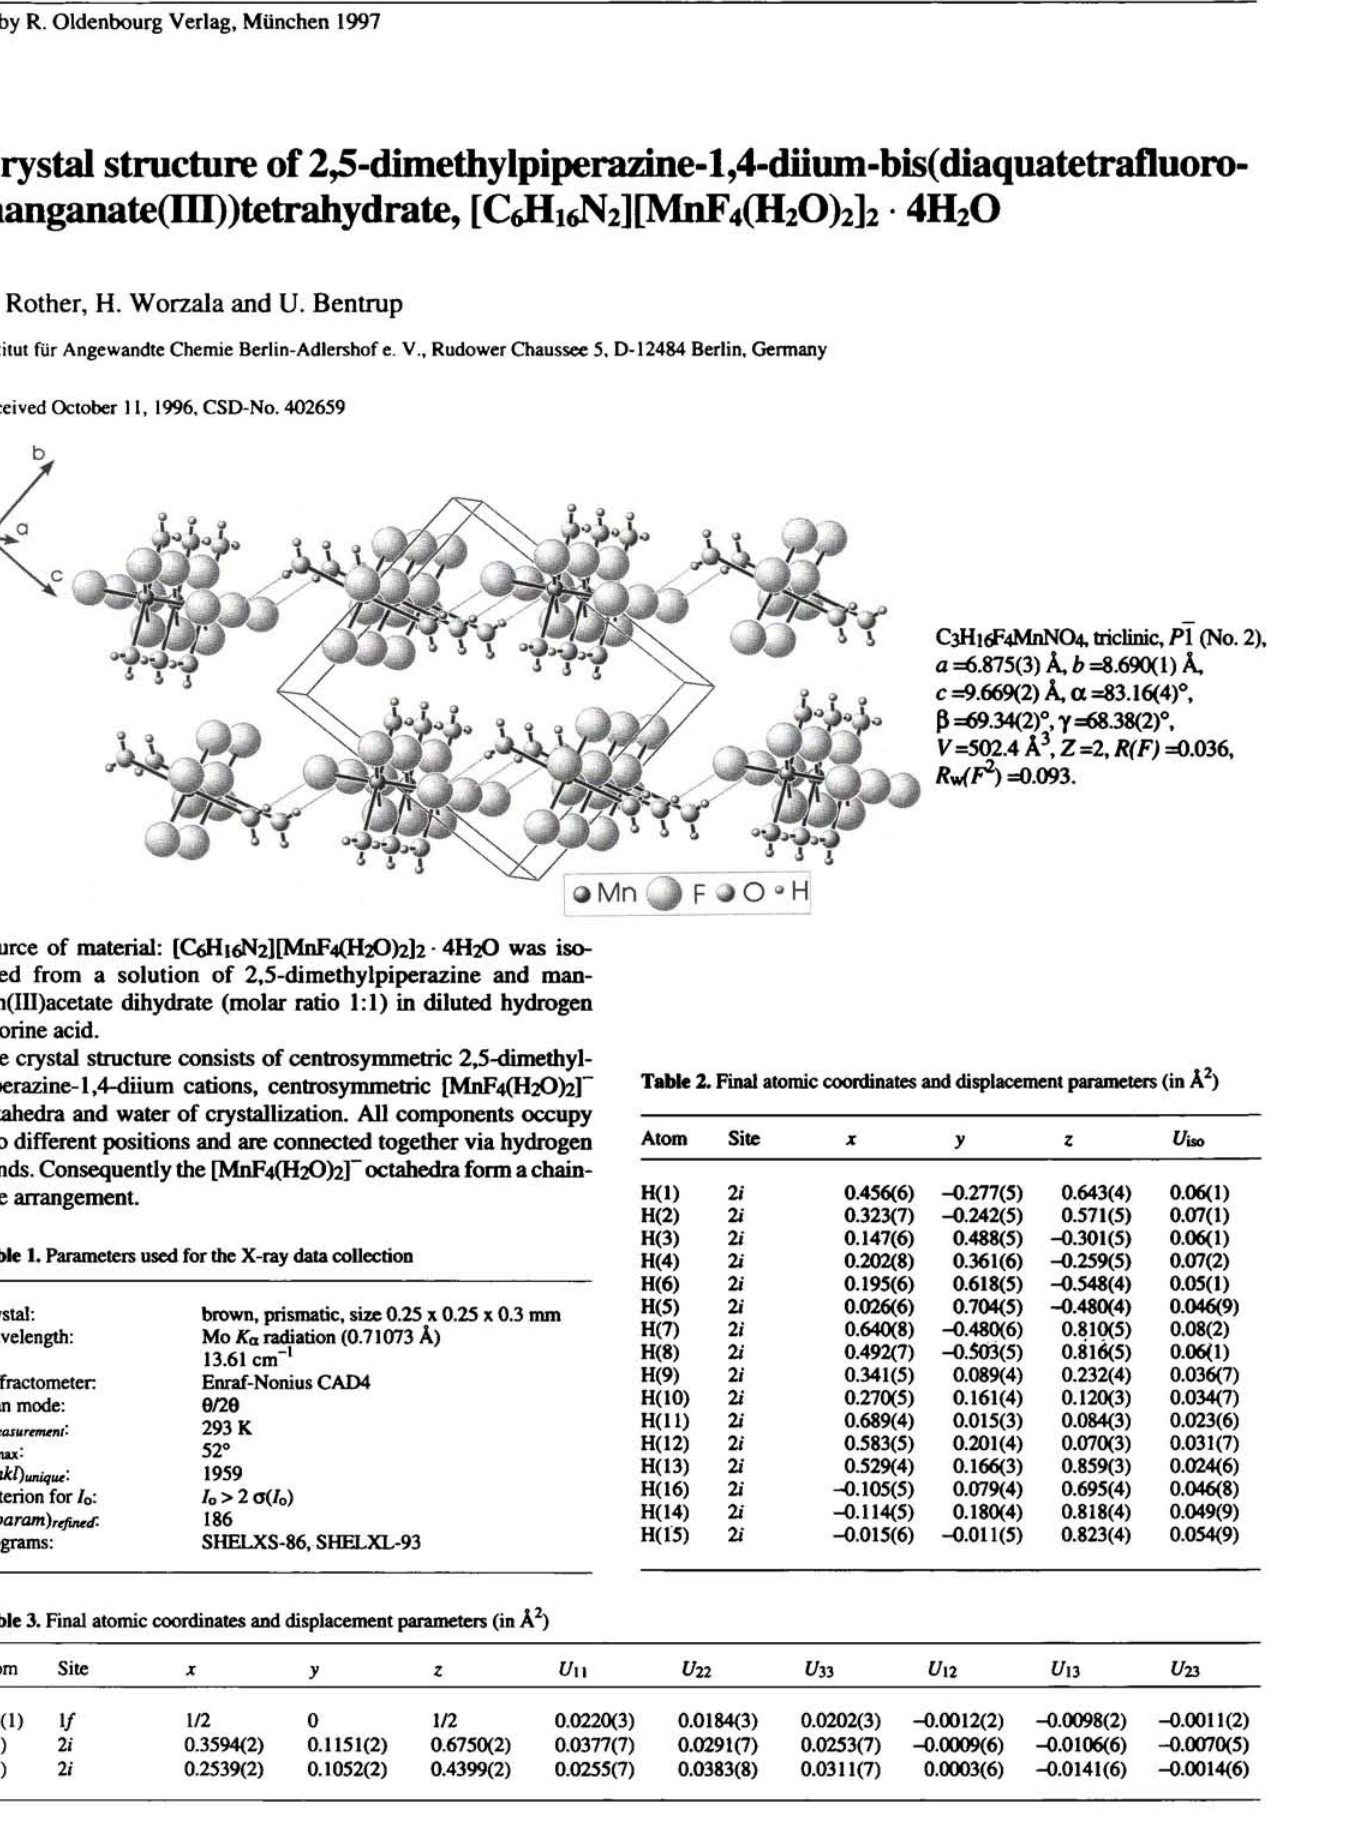
Table 1. Parameters used for the X-ray data collection Crystal: